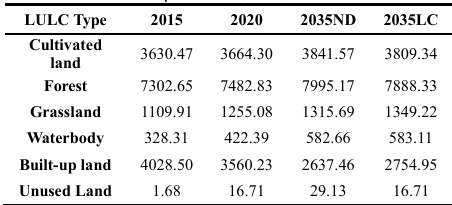
Table 3. LULC change in the study area during different periods (km 2 ).